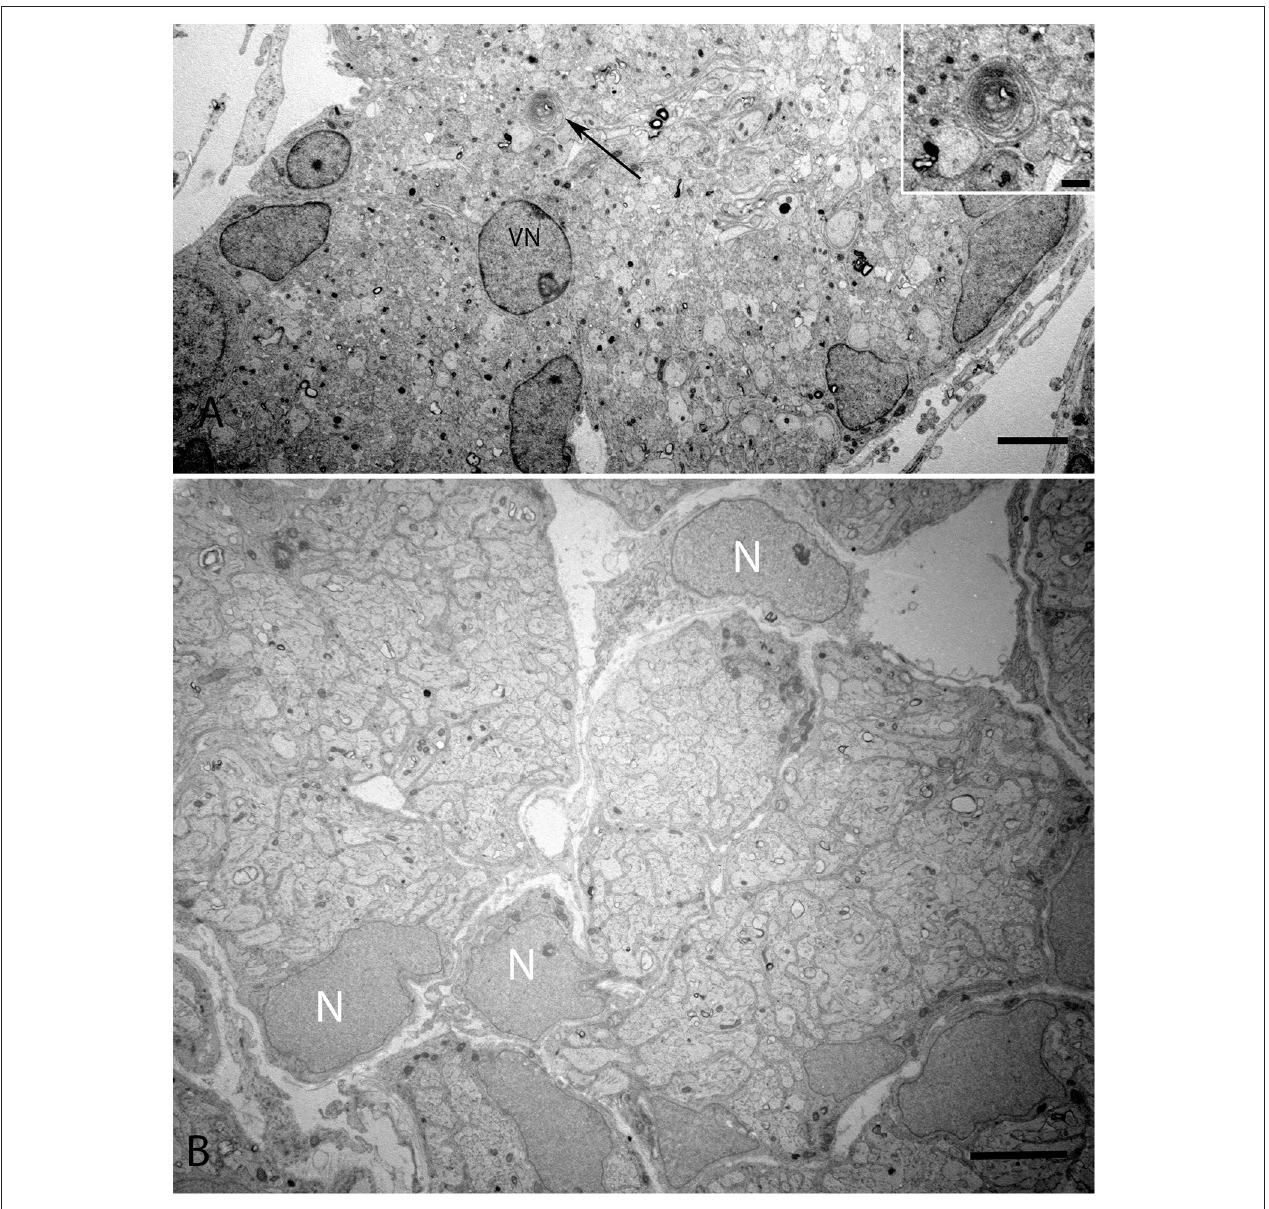
FIGURE 9 | Overview of the vestibular nerve close to the ganglion in the human fetal VO with the onset of myelin formation (arrow) visible in (A). Inset image exhibits the loose myelin structures. The vestibular neuron (VN) can clearly be distinguished by the nucleus structure, while other cell types possess high variability in cell nucleus structure. These cells surround nerve fibers, most of them are probably non-myelinating Schwann cells starting to wrap axons. (B) visualizes an adjacent portion of the vestibular nerve where the compartmentalization of the fascicles have already occurred with highly active nuclei (N) with no heterochromatin visible. Scale bar: 2 µ m (A,B) , 500nm ( A ,